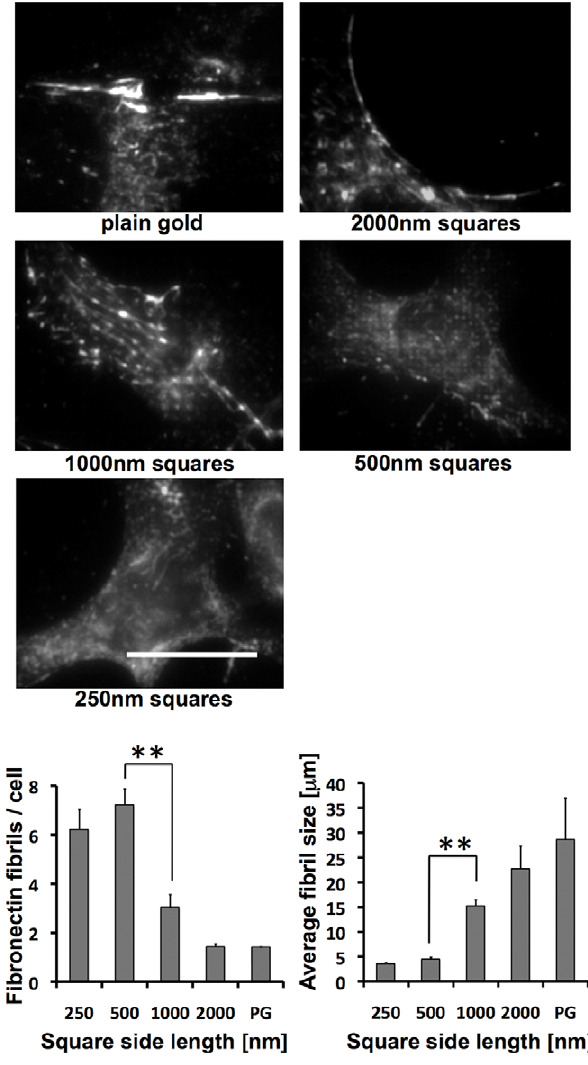
Figure 6. Fibroblasts on RGD-gold squares smaller than 1 m m 2 form short and thin fibronectin fibrils. Cells were grown on RGD- coupled gold patterns for 4 hours with 3% fibronectin free serum and subsequently fixed and stained with an anti fibronectin antibody. Note that long fibronectin fibrils are detected only on patterns $ 1 m m 2 and on plain gold (PG). Scale bar is 20 m m. Quantifications of the number (bottom left) and size (bottom right) of fibronectin fibrils with a length . 3 m m per cell are shown by the graphs. Values indicate the mean 6 S.E.M. from three independent experiments including $ 30 cells per pattern size; **p ,